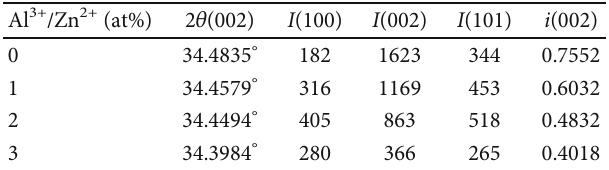
Figure 2: X-ray di ff raction patterns of the ZnO samples formed on FTO substrates by electrodeposition method at a constant potential -1.5 V from 3mM Zn(NO ) aqueous solutions containing Al(NO 3 2 3 at%, at 80 ° C for 60 min with a fi xed electrode distance of 2cm. Table 1: Position and intensity of the characteristic peaks of ZnO samples in Figure